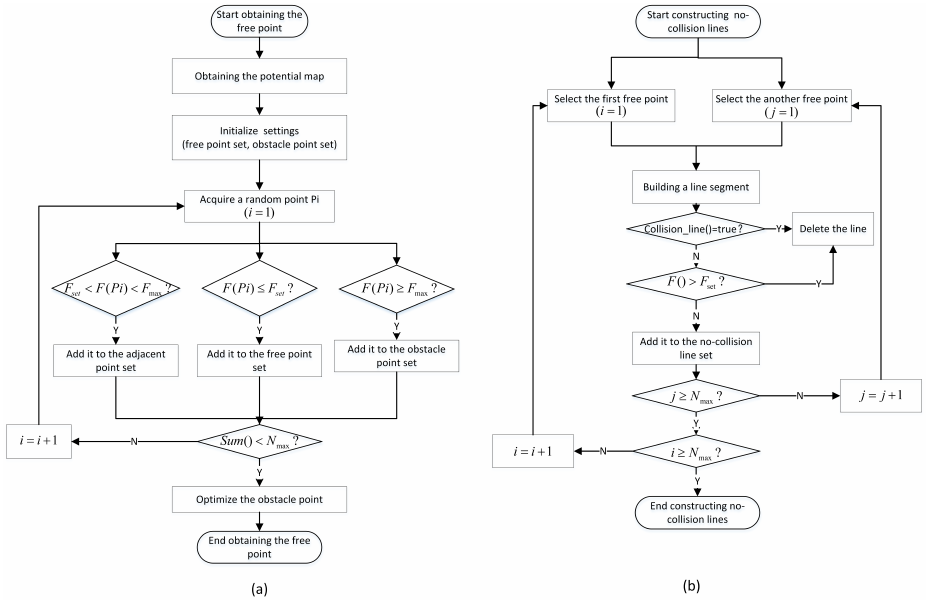
Figure 3. The learning process of the optimized PRM algorithm.( a ) Obtaining free points; and ( b ) constructing collision-free line segments based on the optimized PRM